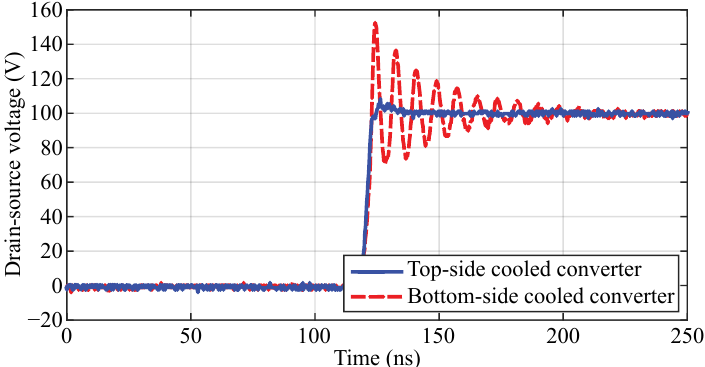
Figure 18. Comparison between the experimental drain-source voltages of the studied converters. The parasitic inductances of the studied converters were determined using Equation (26). The bottom-side cooled converter featured a parasitic inductance equal to 4.84 nH, a value close to the one obtained by simulations. The top-side cooled con- verter exhibited an inductance of 0.57 nH, a value similar to that obtained analytically. Hence, the bottom-side cooled converter has a parasitic inductance 8.49 times higher than the top-dissipated converter. Table 5 summarises and compares all the obtained parasitic